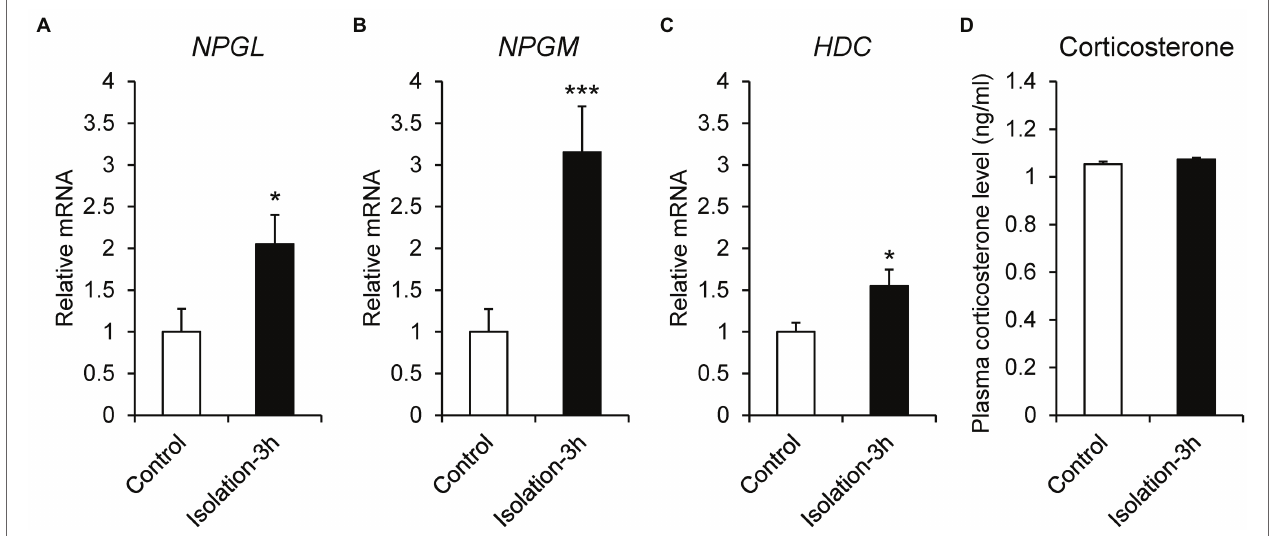
FIGURE 4 | mRNA expression levels, neurosecretory protein GL ( NPGL ; A ), neurosecretory protein GM ( NPGM ; B ), histidine decarboxylase ( HDC ; C ) in the mediobasal hypothalamus in the isolation stress experiment for 3 h. Plasma corticosterone concentration level (D) . Data are expressed as the mean ± SEM ( n = 5–6). Data were analyzed by Student’s t -test. An asterisk indicates a statistically significant difference (* p < 0.05, *** p <